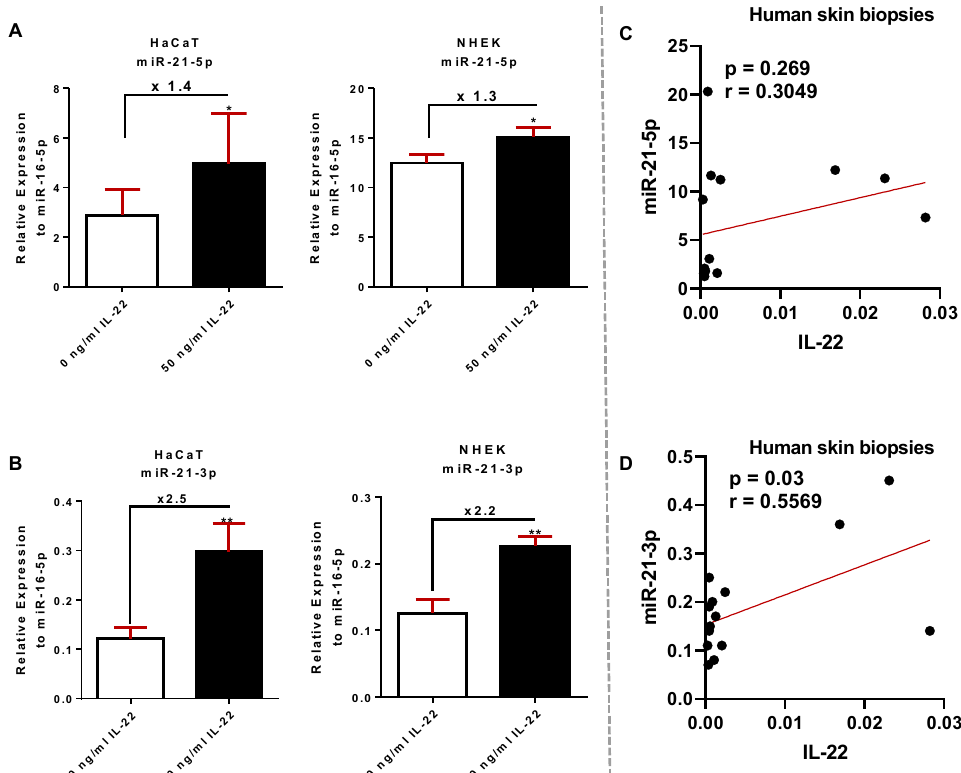
Figure 2. IL ‐ 22 correlates with miR ‐ 21 ‐ 3p and to a minor extent with miR ‐ 21 ‐ 5p induction. ( A ) RT ‐ qPCR quantification on the relative expression of miR ‐ 21 ‐ 5p compared to miR ‐ 16 ‐ 5p levels in HaCaT cells and NHEKs stimulated with 50 ng/mL IL ‐ 22 for 24 h. ( B ) RT ‐ qPCR quantification of the relative expression of miR ‐ 21 ‐ 3p compared to miR ‐ 16 ‐ 5p levels in HaCaT cells and NHEKs stimulated with 50 ng/mL IL ‐ 22 for 24 h. ( C ) Pearson correlations between relative the expression of miR ‐ 21 ‐ 5p and IL ‐ 22 in human skin biopsies from healthy ( n = 10) and psoriatic individuals ( n = 9). ( D ) Pearson correlations between the relative expression of miR ‐ 21 ‐ 3p and IL ‐ 22 in human skin biopsies from healthy ( n = 10) and psoriatic individuals ( n = 9). Data information: results are presenteds as mean values ± SEM. Data are representative of three independent experiments done in triplicates. The statistical comparison between groups was performed by using a two ‐ tailed Student’s t ‐ test: * p < 0.05, ** p < 0.01.